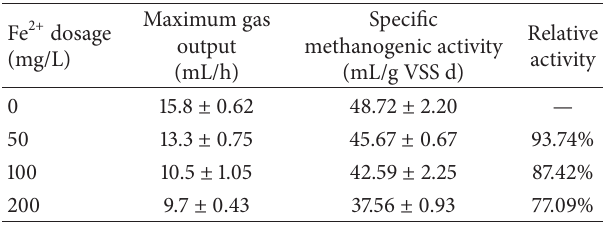
Table 1: The effect of Fe 2+ on methanogenic activity of NZVI@SiO /anaerobic granule sludge system. NH 2